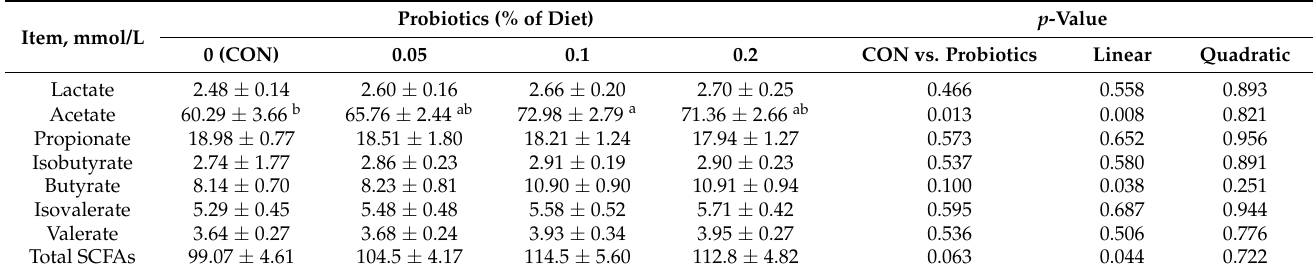
Table 8. Effects of dietary complex probiotic supplementation on fecal SCFAs in growing